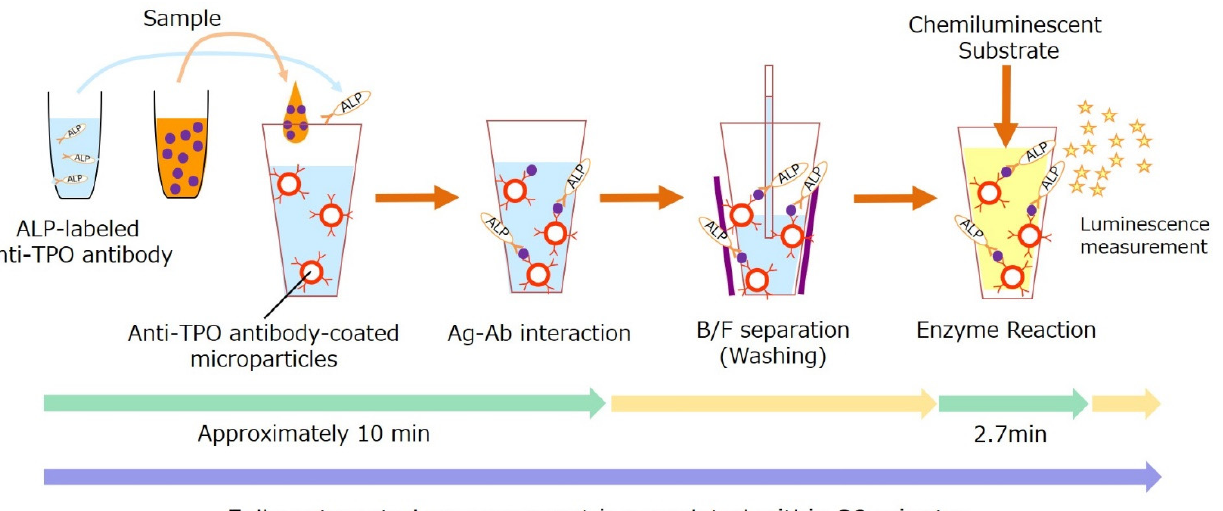
Figure 1. Schematic representation of TPO measurement using a one-step sandwich method. AB, antibody; Ag, antigen; ALP, alkaline phosphatase; TPO,